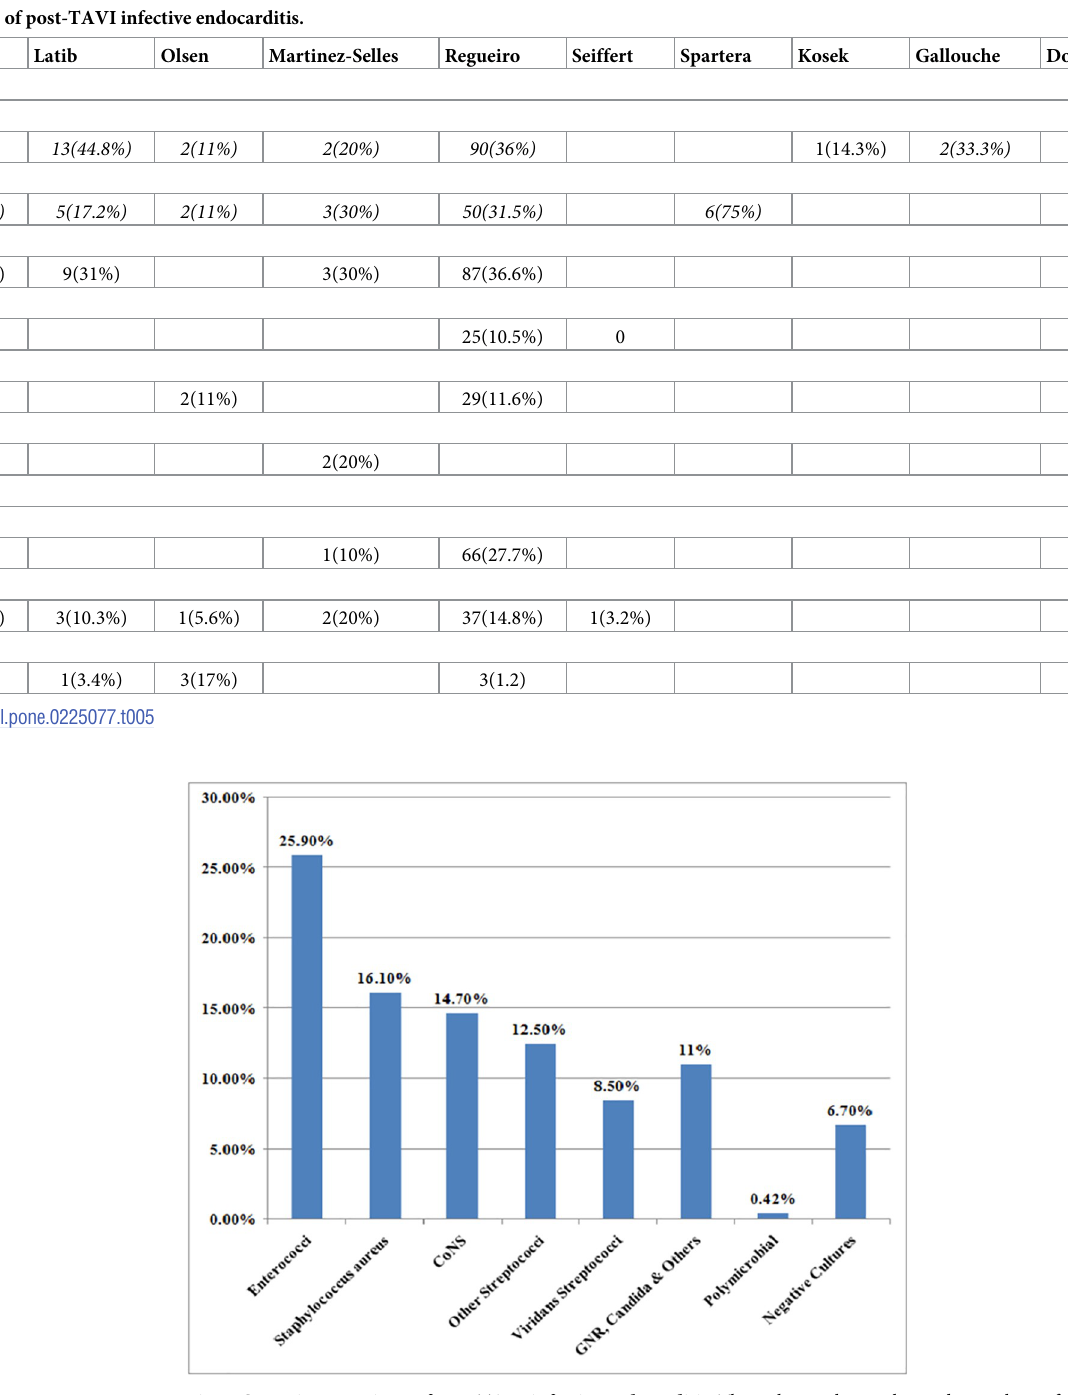
Fig 5. Causative organisms of post-TAVI infective endocarditis. The in-hospital mortality and mortality at follow- up were assessed in 7 studies with the mean incidence of 29.5% in-hospital mortality and 29.9% mortality at follow-up. The incidence of heart failure after post-TAVI infective endocarditis was reported in 5 studies making a cumulative incidence of 37.1%. Two studies determined the incidence of stroke with the stroke occurring in 10.5% and 0% post- TAVI infective endocarditis patients. Major bleeding was reported in 2 studies with an average of 11.3%. Only a single study by Martinez-Selles et al. reported arrhythmias in 20% cases. The septic shock occurred in 10% and 27.7% post- TAVI infective endocarditis patients according to 2 studies. The surgical intervention for the treatment of post-TAVI infective endocarditis was reported in 7 studies with the mean of 11.4%. Four studies revealed the valve-in-valve procedure performed in an average of 6.4% cases. The clinical outcomes of post-TAVI infective endocarditis are shown in Fig 6.